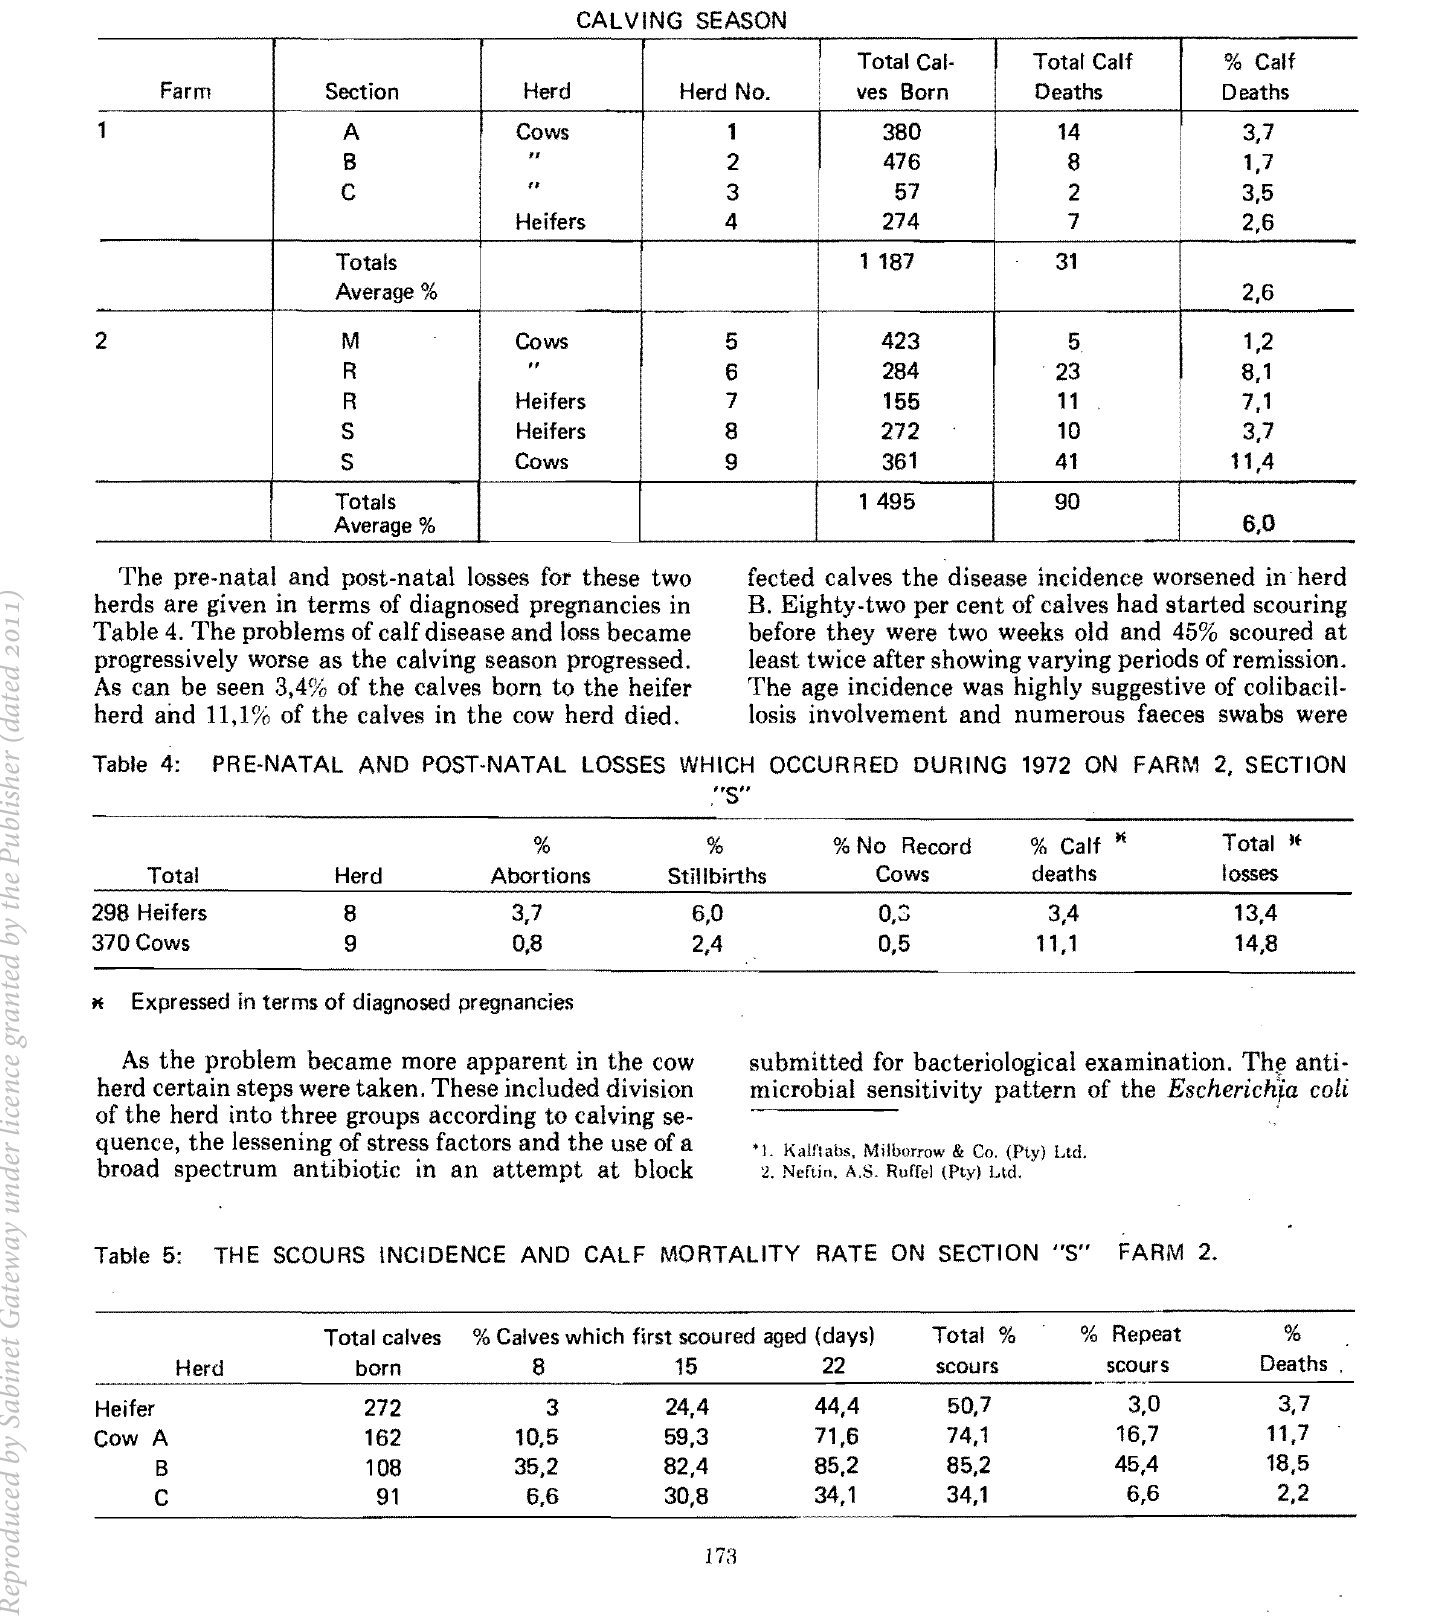
TOTAL NUMBER OF CALVES BORN ALIVE AND LOSSES ON BOTH FARMS DURING THE 1972 CALVING SEASON I Total Cal- Total Calf % Calf Farm Section Herd Herd No. ves Born Deaths